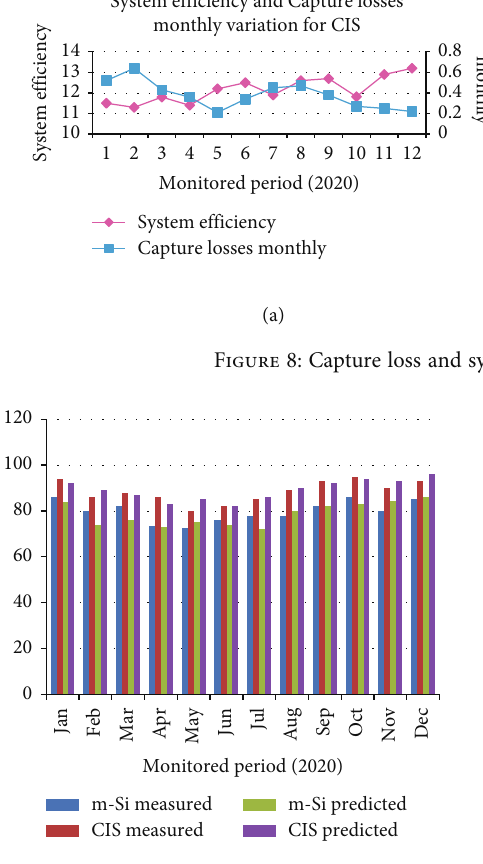
Figure 9: CIS and m-Si PV array ’ s predicted and measured PR comparison.